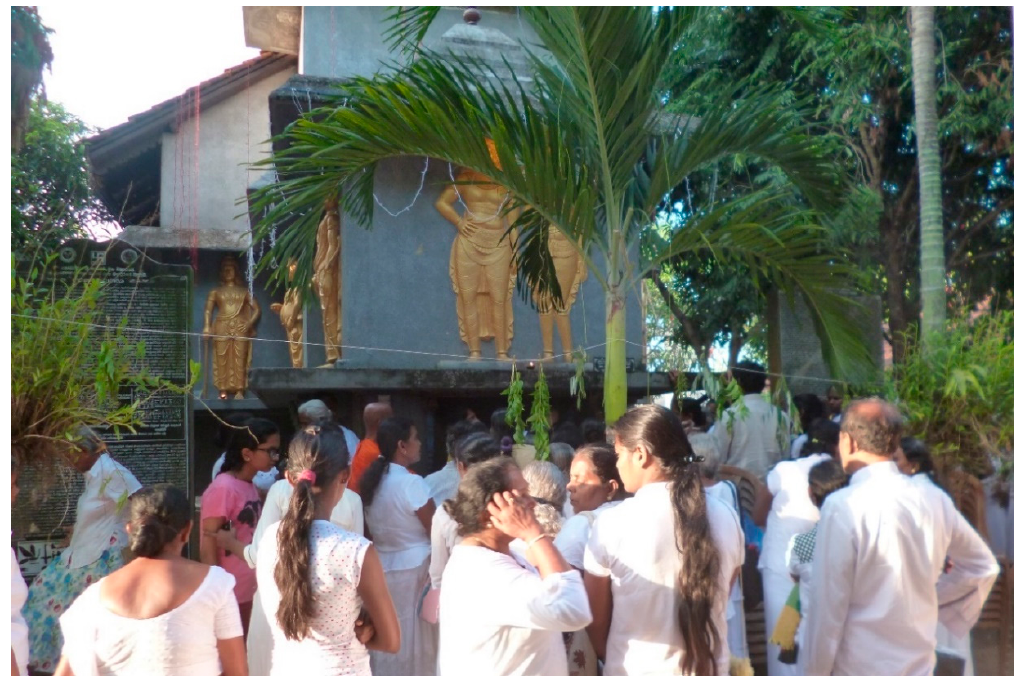
Figure 7. People queuing up at the back side of the Ravana mandiriya to ‘bathe’ themselves with the substances used for the annual maha Ravana nanumura mangalyaya. Picture taken by author, 26 March 2017.